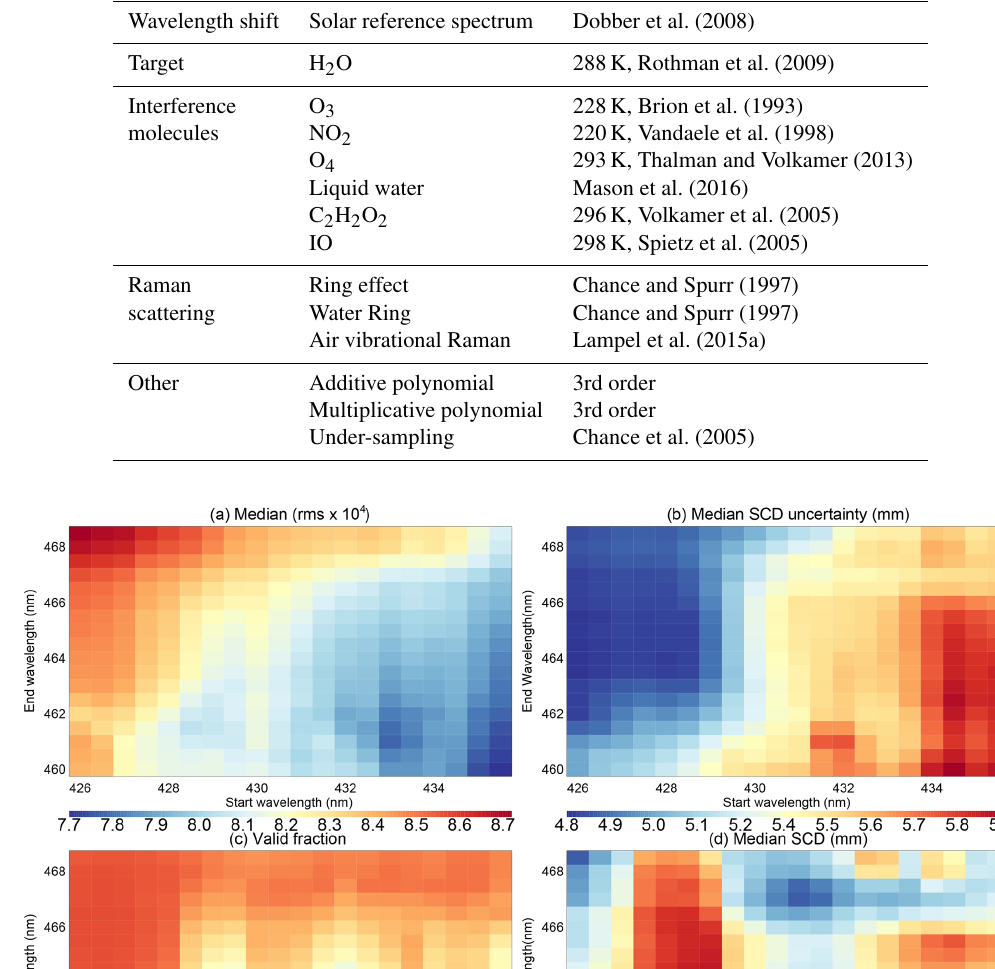
Table 1. Parameters used in the version 4.0 spectral fitting for OMI total column water vapor.